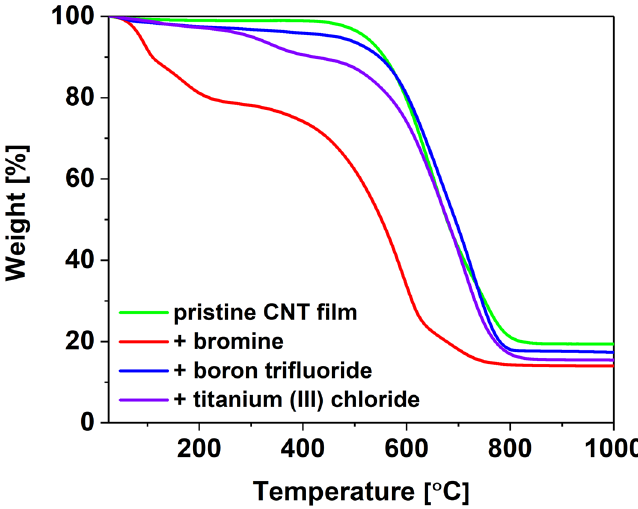
Figure 2. Thermograms of a CNT film before and after doping with inorganic halide compounds.